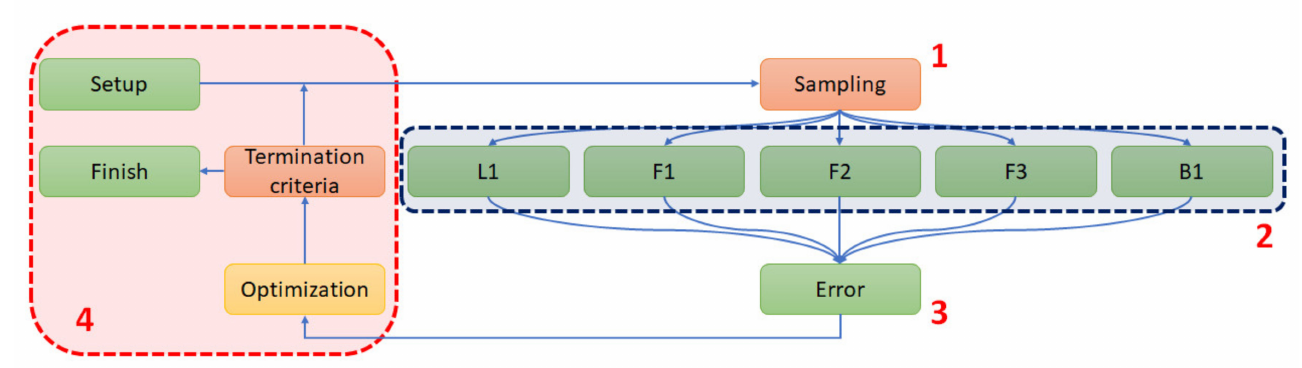
Figure 12. Optimization procedure: ( 1 ) sampling of variables, ( 2 ) parallel numerical analysis of five samples, ( 3 ) calculation of error norms, and ( 4 ) optimization